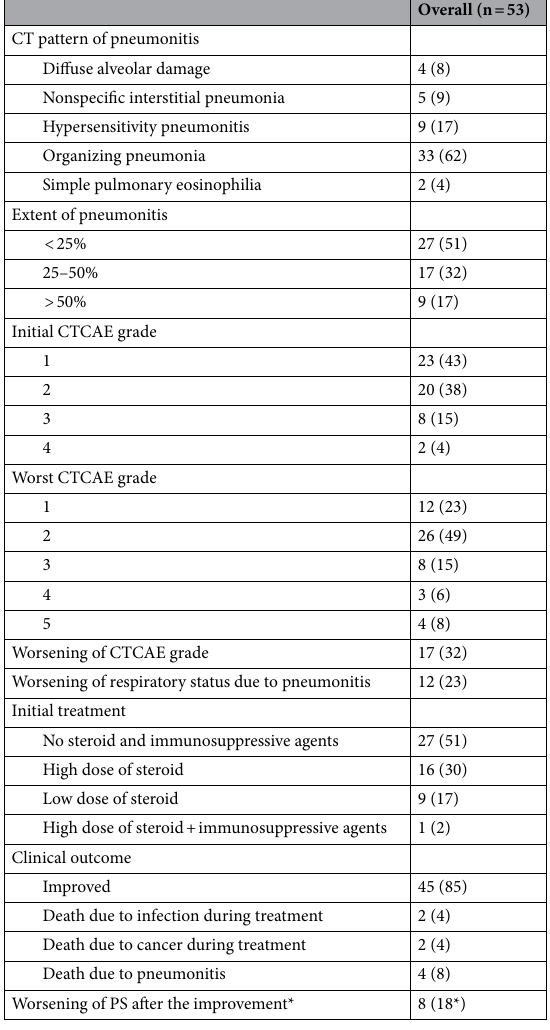
Table 2. Clinical features and management of pneumonitis. Abbreviations: CT computed tomography, CTCAE Common Terminology Criteria for Adverse Events. *Among the 45 patients who